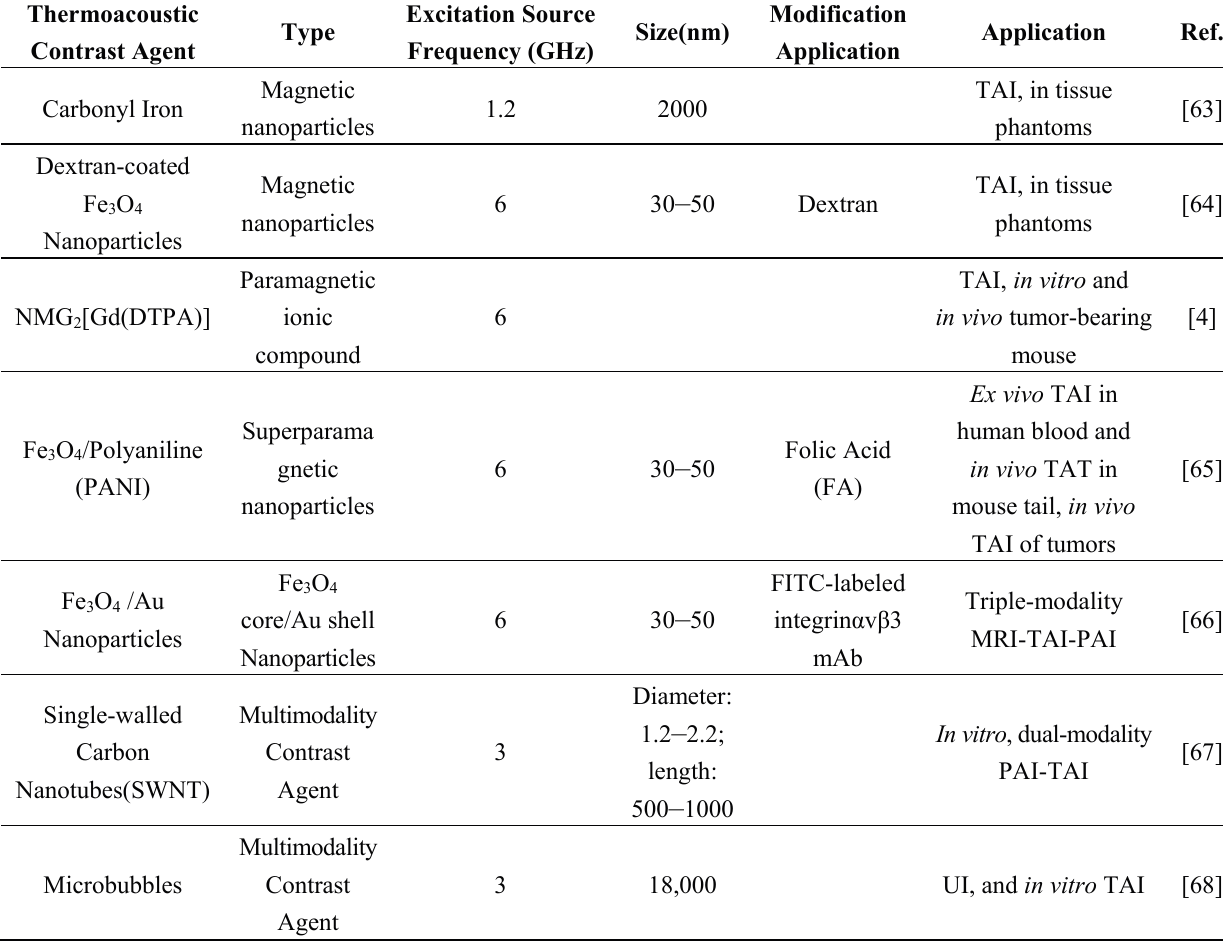
Table 2. Contrast agents for thermoacoustic imaging.